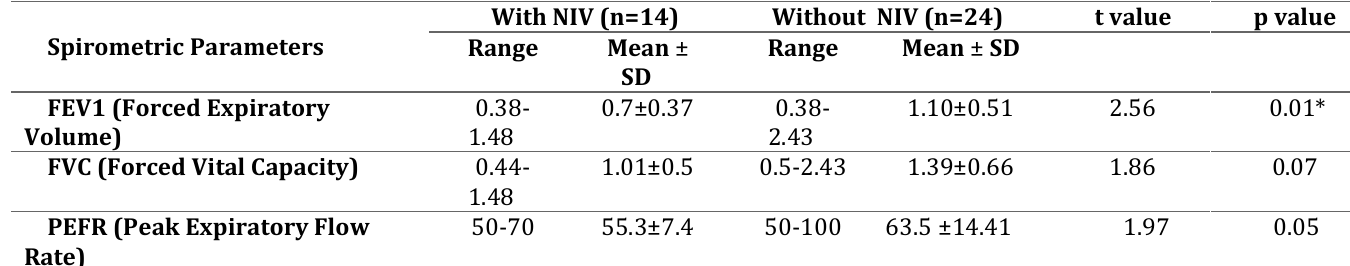
Table 4: Spirometric Parameters of individuals with & without NIV of patient at high risk of Acute Respiratory Failure